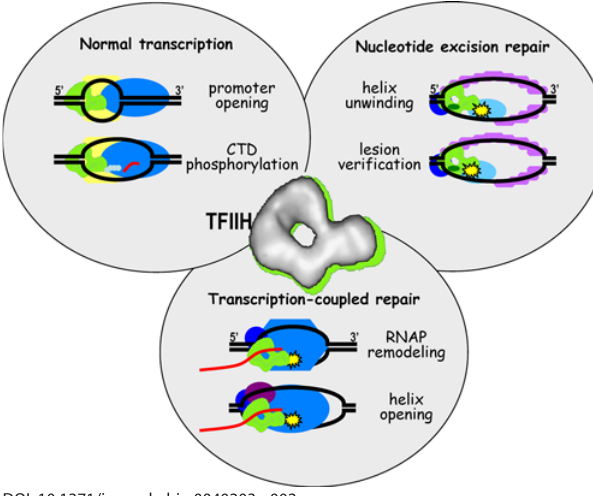
Figure 2. TFIIH Is a Multi-Functional Protein Complex TFIIH participates in normal transcription, NER, and TCR and has multiple functions in each of these processes. A medium-resolution electron microscopy structure of the human TFIIH complex [36] shows that TFIIH forms a ring-like structure with a protrusion that contains the CAK kinase (“tricho”) with malformed (“dystrophy”) hair shafts, fi sh- like scales on the skin, mental and physical retardation, and sun sensitivity in some complementation groups [10].